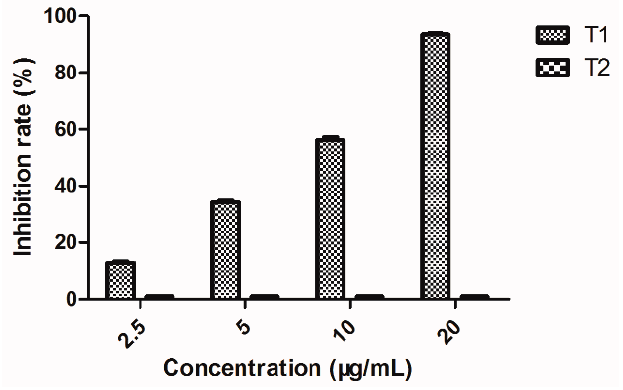
Figure 6. Inhibition rate of EPS of Xoo (The data presented are the mean ± SD). T1 : Xoo + Compound 2-(methylsulfonyl)-5-(4-fluorophenyl)-1,3,4-oxadiazole; T2 : Untreated blank